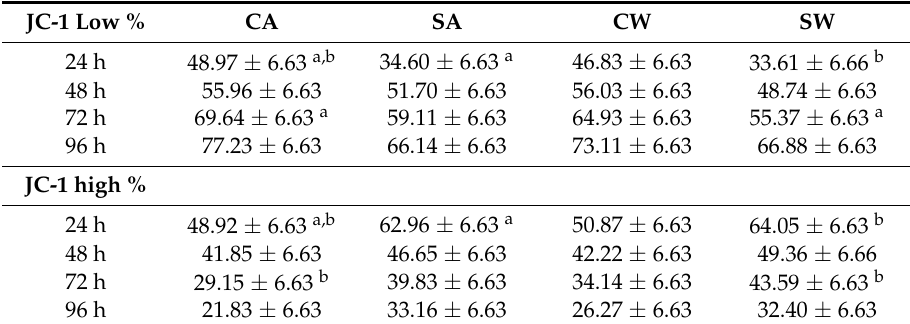
Table 2. Mitochondrial membrane potential for control and treatment groups, with and without antibiotics (Least Squares Means ± Standard Error; n = 18).